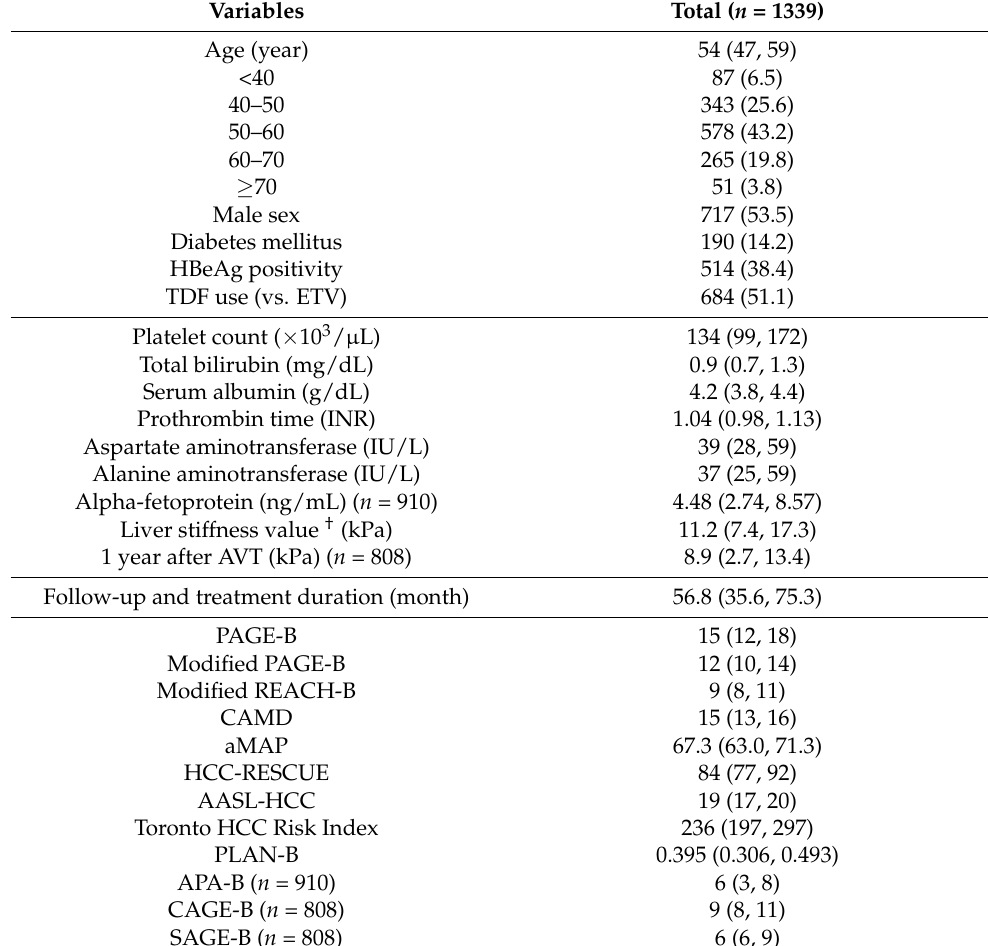
Table 1. Baseline clinical characteristics of the study